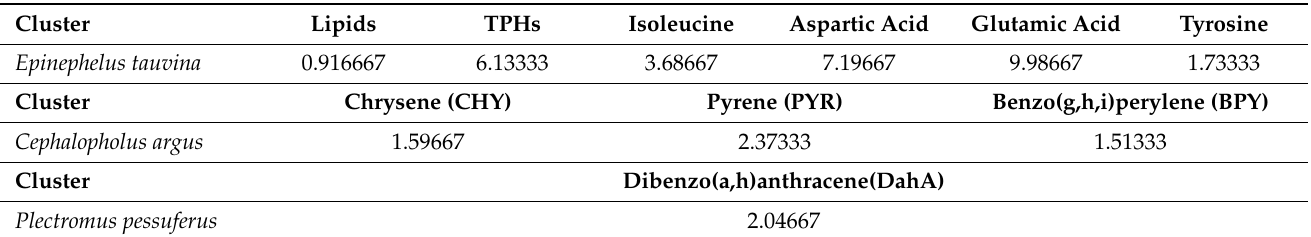
Figure 6. Dendrogram showing the clusters formed by the studied fish species. The assignments of the clusters with the parameters according to their possible pollu- tion sources are given in Table 14. Table 14. Sensitivity of fish species to pollution sources.